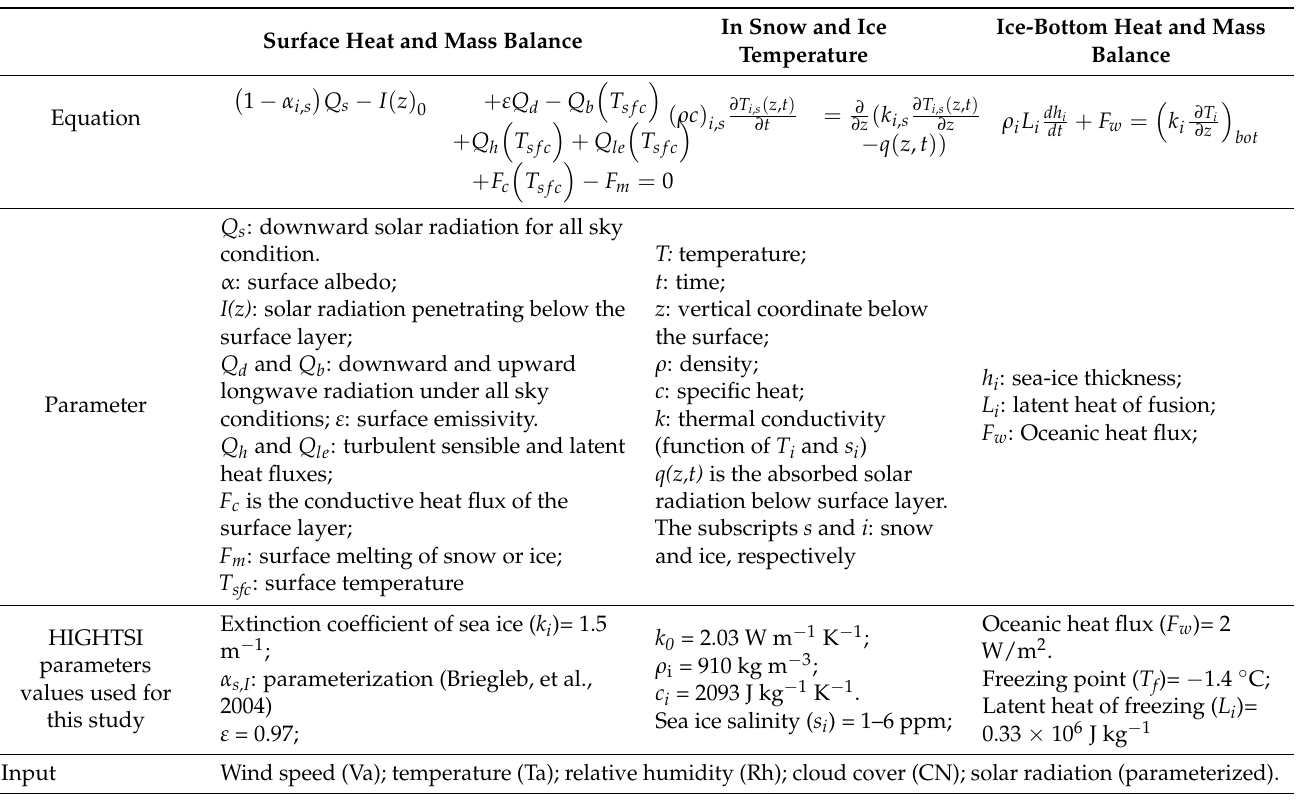
Table 1. Major components of HIGHTSI model and parameters used for this study. Surface Heat and Mass Balance